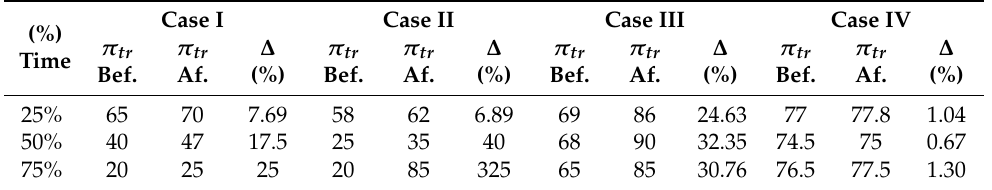
Table 3. Effect on the transaction prices (EUR/MWh) for information of 100% outage Ther 1 at different trading times and for different pricing strategies. (First column: Share of trading horizon reached at outage in %) (Bef.: Before, Af.: